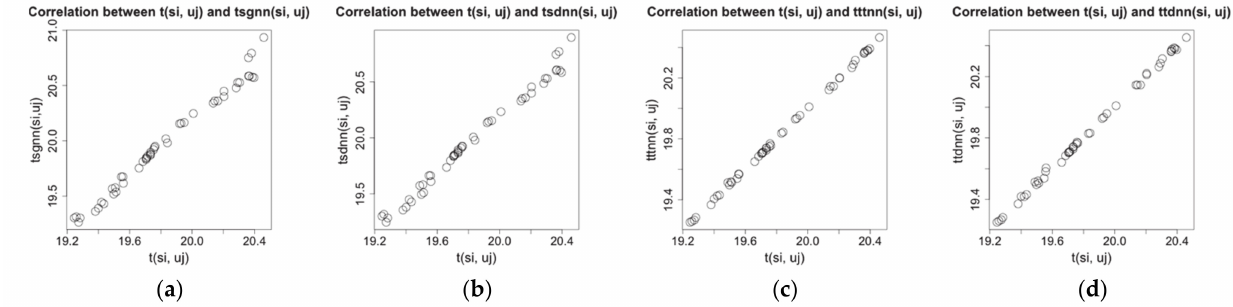
Figure 1. Correlation between raw temperature values and spatial (temporal) nearest neighbor values on Intel Lab dataset.